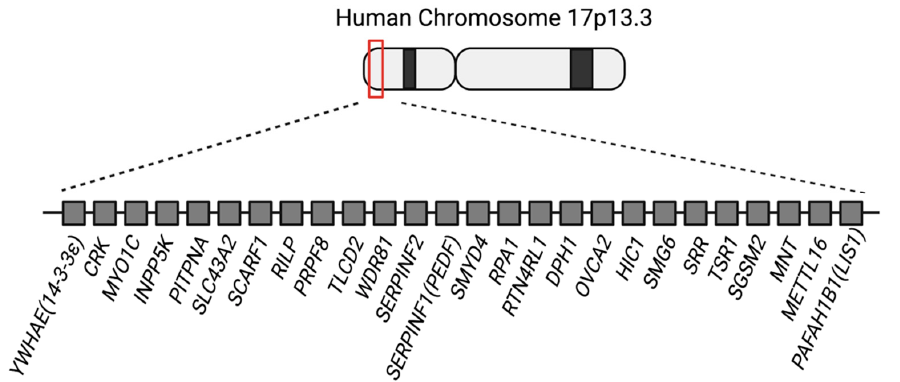
Figure 1. Schematic illustration of the 26 genes in the human chromosome 17p13.3 Miller–Dieker syndrome critical region.